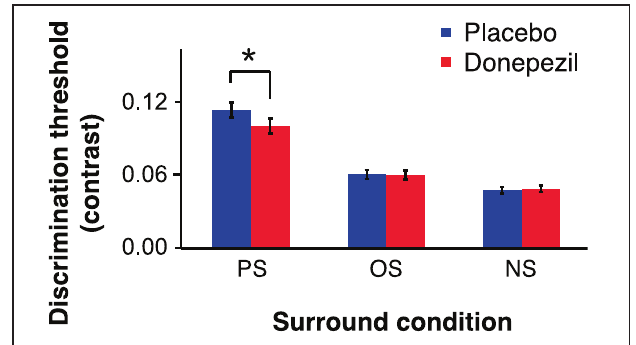
FIGURE 3 | Contrast discrimination thresholds for parallel surround (PS), orthogonal surround (OS), and no surround (NS) conditions ( ∗ , p < 0 . 05). Error bars represent ± 1 SEM of the within-subject difference between the placebo and donepezil conditions in each surround condition. FIGURE 4 | Surround suppression indices. Each index represents the